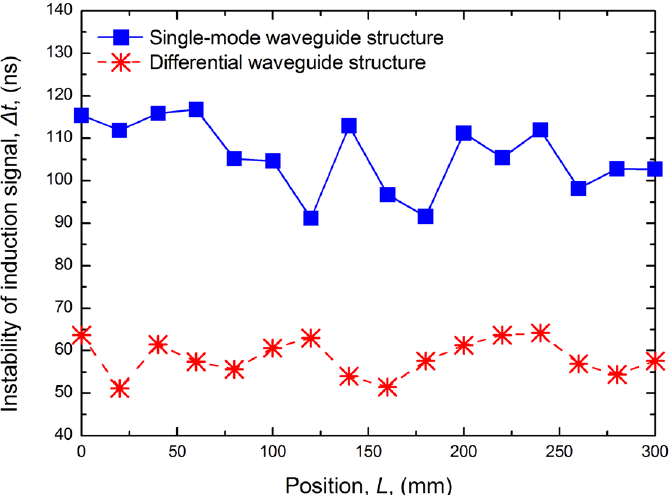
Figure 9. Comparison of induction signal